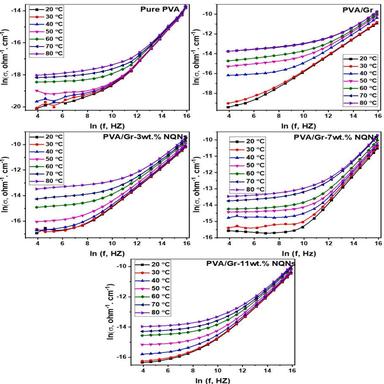
ln (σ) as a function of ln (f) for the pure PVA and the fabricated PNCs (PVA/Gr, PVA/Gr-3 wt% NQNs, PVA/Gr-7 wt% NQNs, and PVA/Gr-11 wt% NQNs). The measurements were conducted at temperatures (20–80 ◦C) and at different applied frequencies starting from 50 Hz up to 8 MHz.